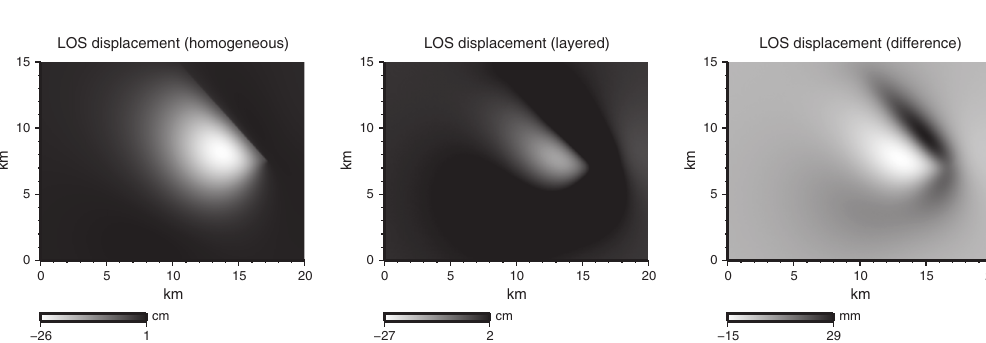
Fig. 2. Map of synthetic LOS displacements generated in the HHS (left) and LHS (middle). Right, map of the residuals of the best-fit linear regression between LOS displacements in the HHS and LHS.